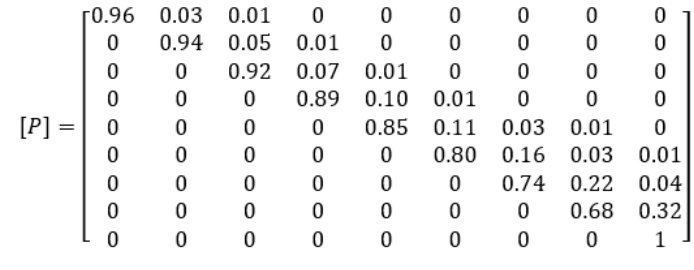
Figure 1. Status transition matrix.